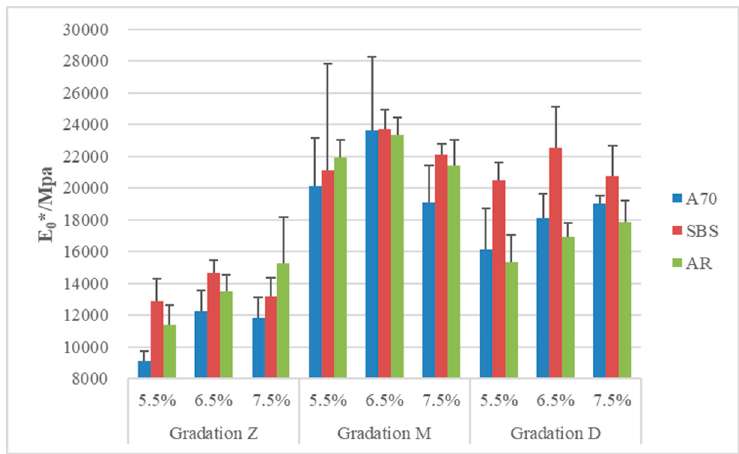
Figure 9. E 0 * of asphalt mixtures (MPa).